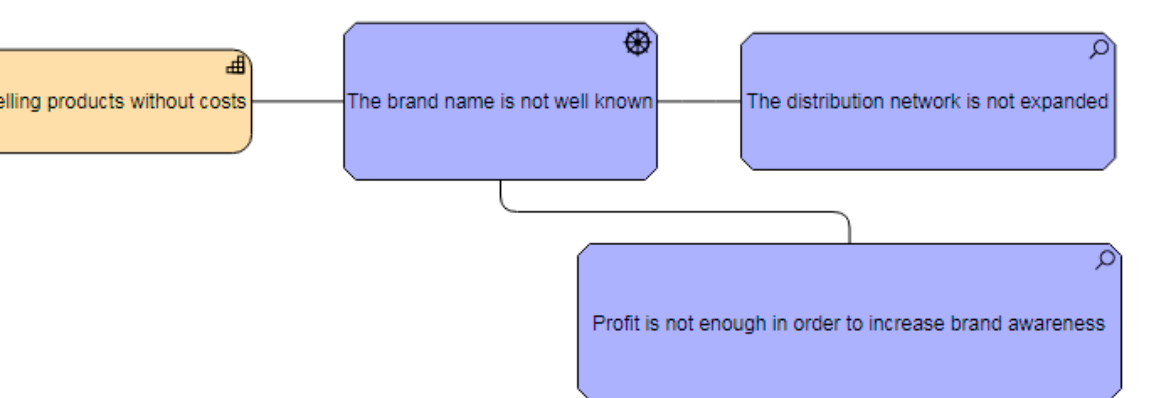
Figure 8. The link between capabilities and external factors.